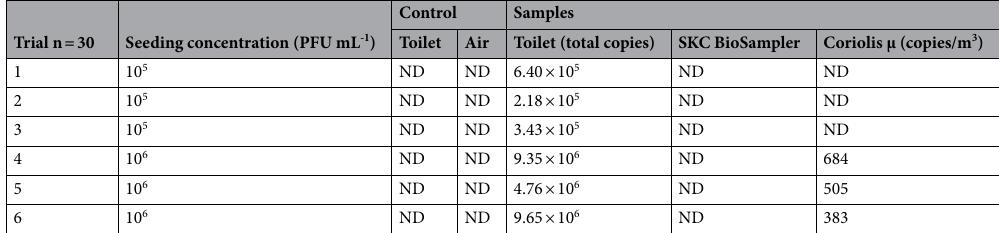
Table 5. Concentrations of MNV from all trials for control, toilet, and aerosol